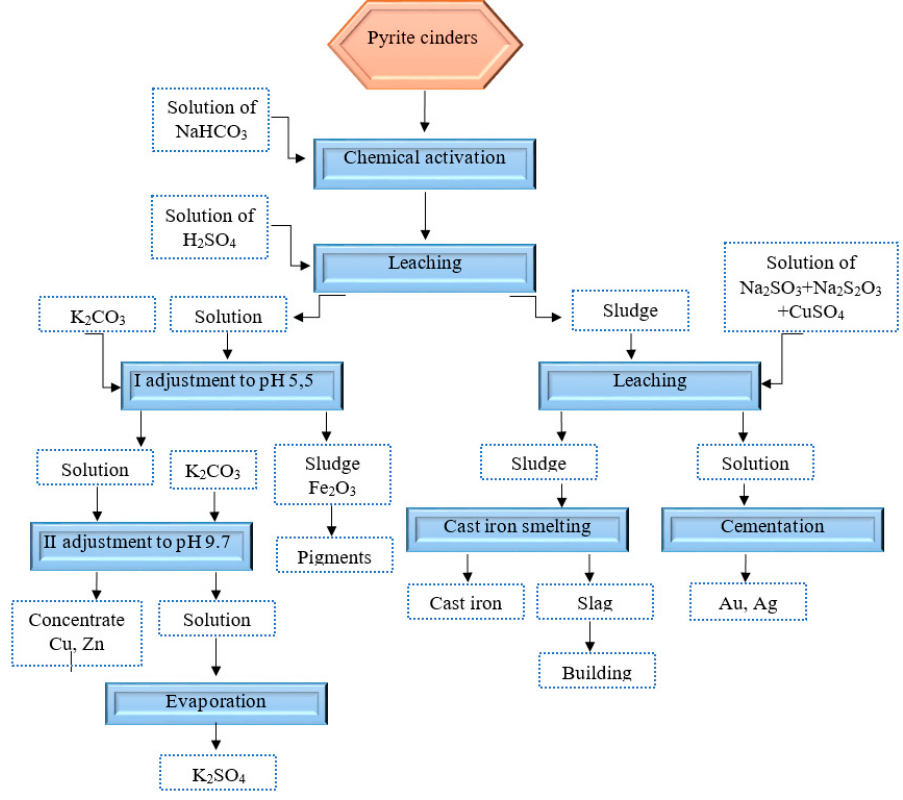
Figure 3. Technological scheme of pyrite cinders processing.